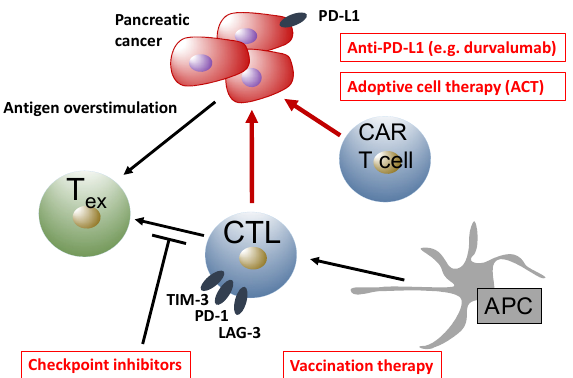
Figure 6. Cross-talk between cancer cells and immune cells mediating immunotherapeutic approaches in pancreatic cancer patients. APC, antigen-presenting cell; CAR, chimeric antigen receptor; CTL, cytotoxic T cell; LAG-3, lymphocyte-activation gene-3; PD-1, programmed death receptor-1; PD-L1, programmed death-ligand 1; T ex , exhausted T cell.